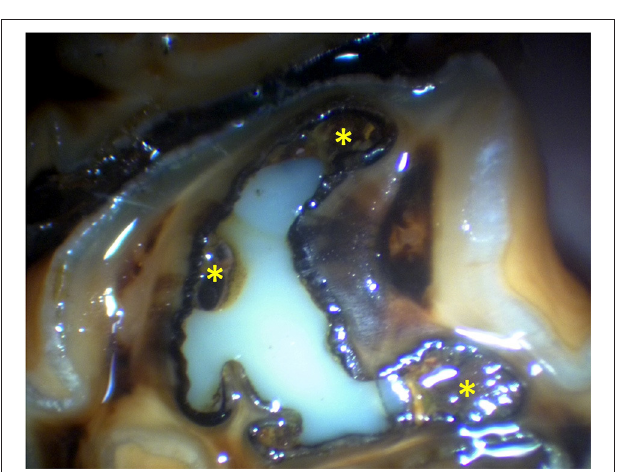
FIGURE 12 | Oroscopic image of a Triadan 209 tooth 9 years post-restoration of the mesial